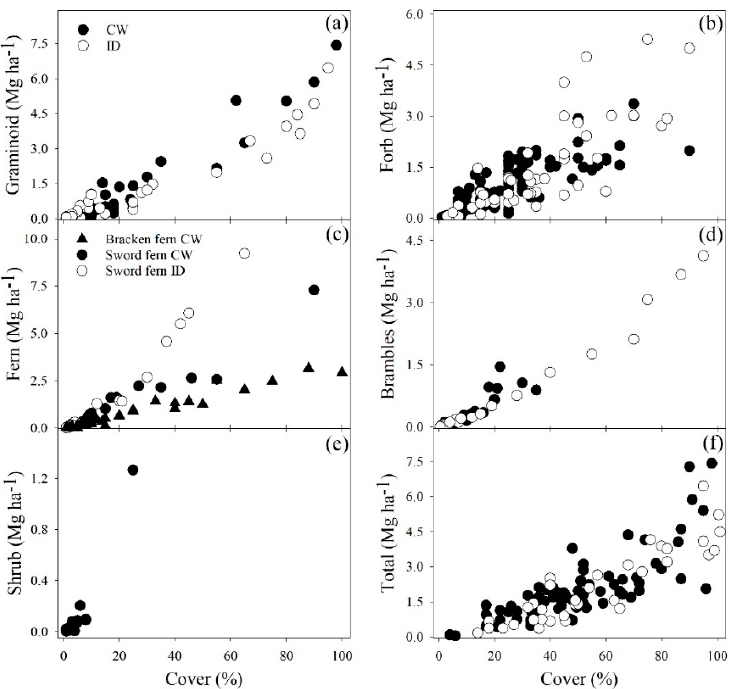
Figure 1. Relationship between cover (%) and biomass (Mg ha − 1 ) for ( a ) graminoids, ( b ) forbs, ( c ) ferns, ( d ) brambles, ( e ) shrubs, and ( f ) total for early-seral vegetation growing at the coastal wet (CW, filled circle) and inland dry (ID, open circle) sites in western Oregon. The fern graph ( c ) includes bracken fern found at the CW site (filled triangle) and the shrub graph ( e ) does not include data from the ID site due to a lack of samples found.